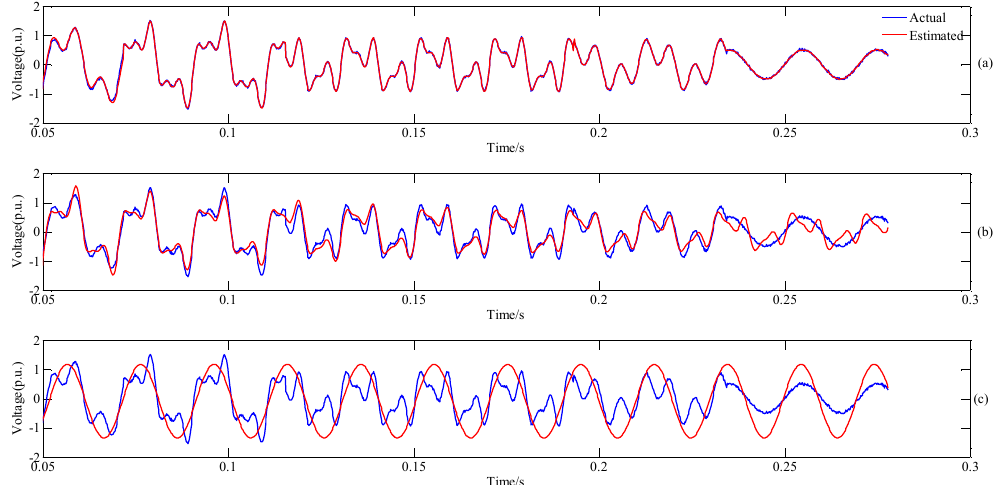
Figure 8. Source signal and the reconstruction of Equation (20) by using ( a ) The proposed method; ( b ) TLS-ESPRIT; ( c ) Prony method.